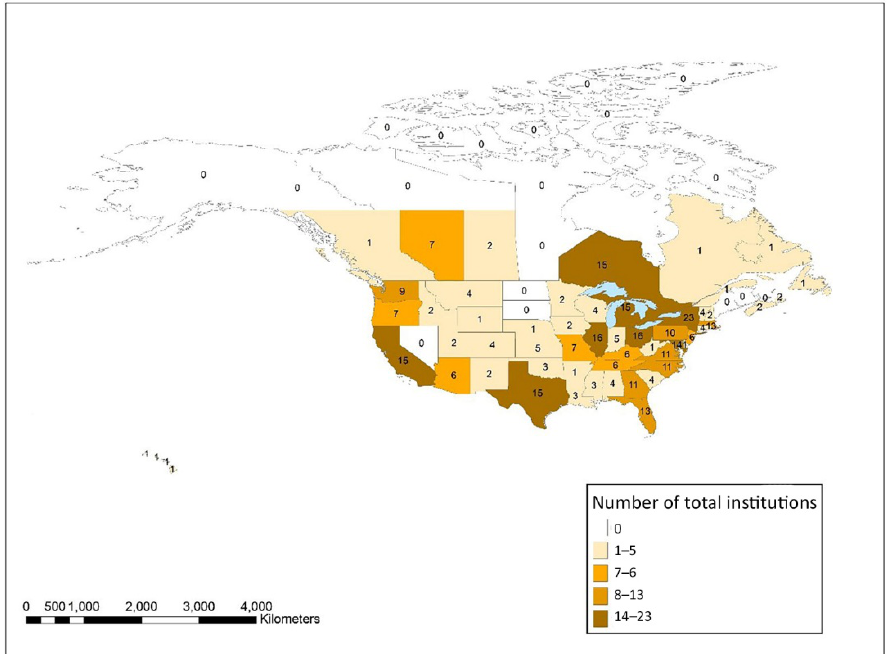
Figure 5 Distribution of the total number of all institution types with at least one JMLA author in the United States and